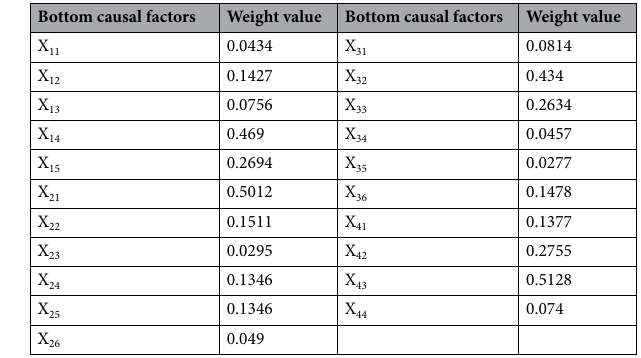
Table 4. Weight coefficients of bottom causal